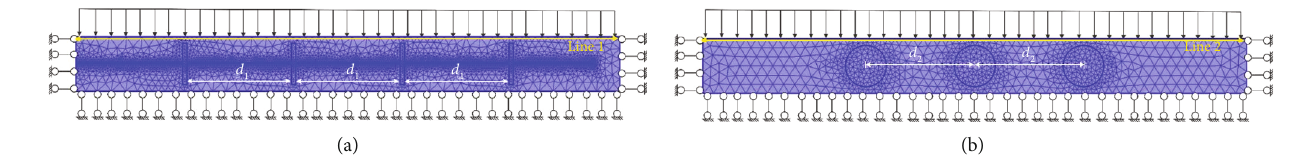
Figure 1: Schematic diagram of numerical simulation and corresponding boundary conditions. Table 1: Main parameters for numerical simulation. Model parameter